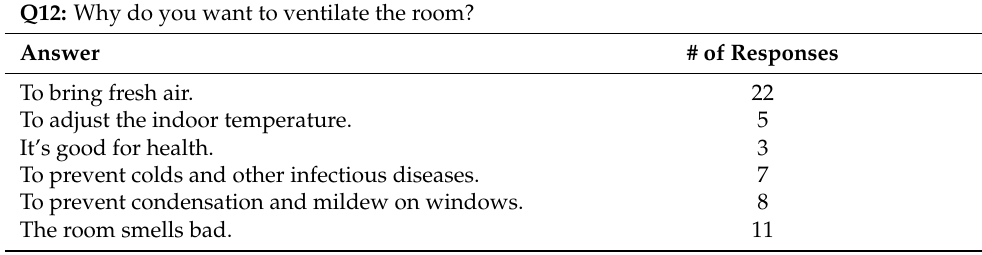
Table 5. Answers to a question about the need for ventilation (multiple answers possible).